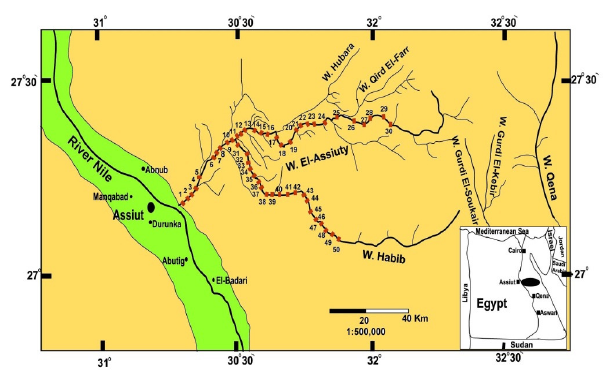
Fig. 1. Location map of Wadi Al-Assiuty and Wadi Habib in the Eastern Desert of Egypt; the stands are given by